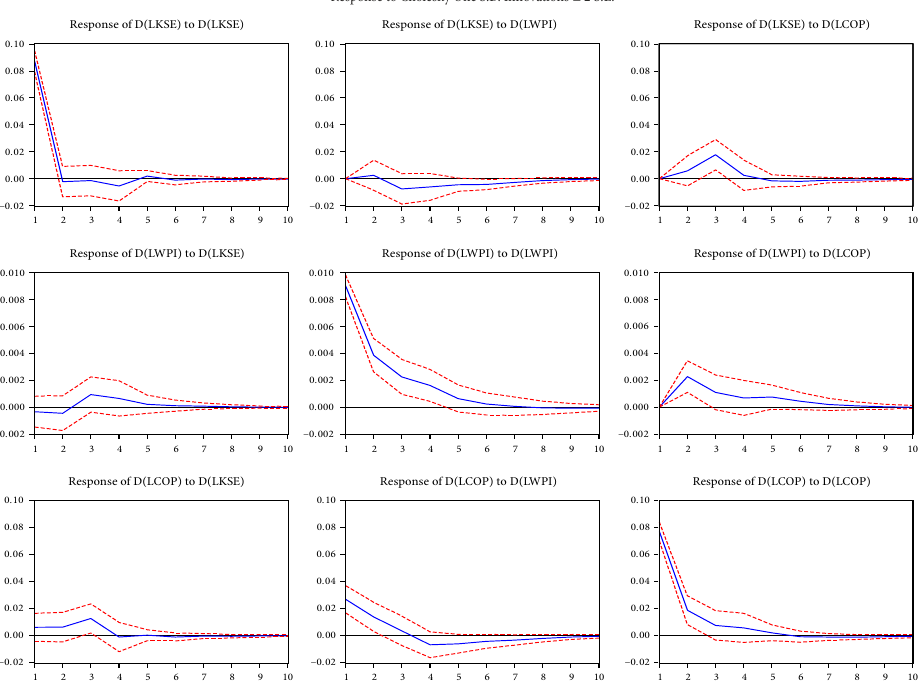
Fig. 4. Impulse Response Function – VAR (DLKSE, DLWPI, DLCOP) Source: Authors’